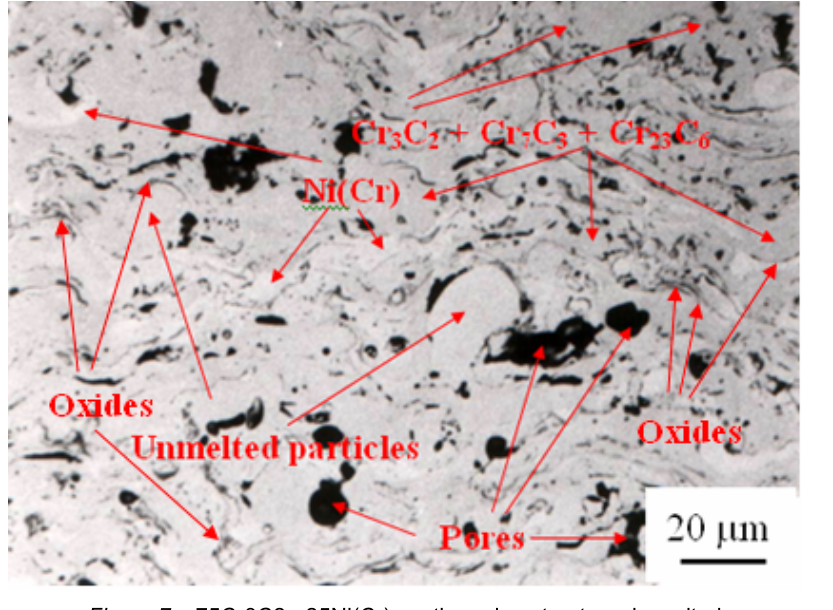
Figure 7 – 75Cr3C2 - 25Ni(Cr) coating microstructure deposited with the powder feed rate of 60 g/min Slika 7 – Mikrostruktura 75Cr3C2 - 25Ni(Cr) prevlake deponovane sa brzinom dovoda praha 60